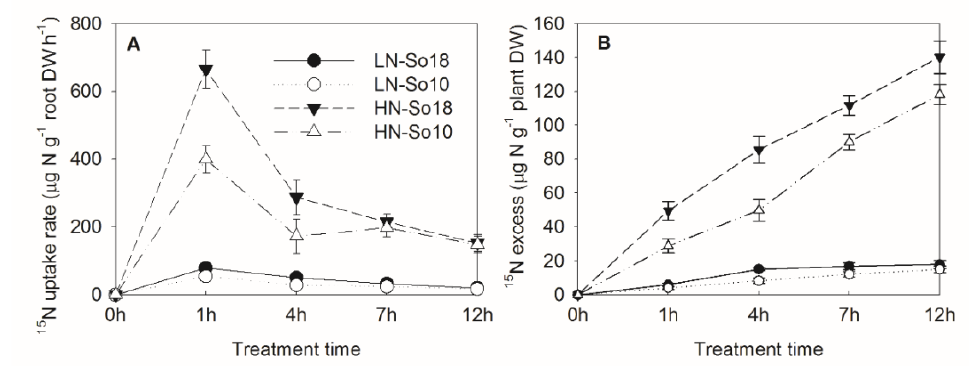
Figure 3. 15 NO 3− -N uptake rate ( A ) and 15 NO 3− -N excess (net NO 3− -N uptake amount) ( B ) of two spinach varieties under low (0.5 mmol·L −1 ) and high (15 mmol·L −1 ) nitrate treatments. Values are provided as mean ± SD, n = 3. LN-So18, So18 treated with low nitrate concentration; LN-So10, So10 treated with low nitrate concentration; HN-So18, So18 treated with high nitrate concentration; and HN-So10, So10 treated with high nitrate concentration.